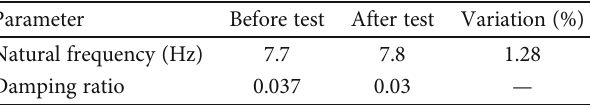
Table 5: Free vibration test results before and after launch vibration